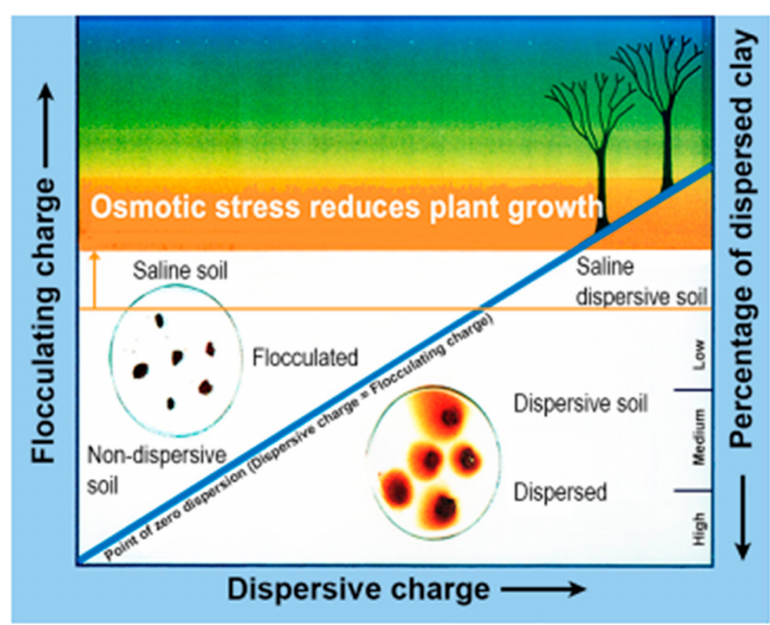
Figure 2. Distinction between saline and sodic (dispersive) soils based on dispersive charge, flocculating charge, and percentage of dispersed clay. (After Rengasamy [37], with permission from MDPI CC BY 4.0). Point of zero dispersion represents threshold electrolyte concentration